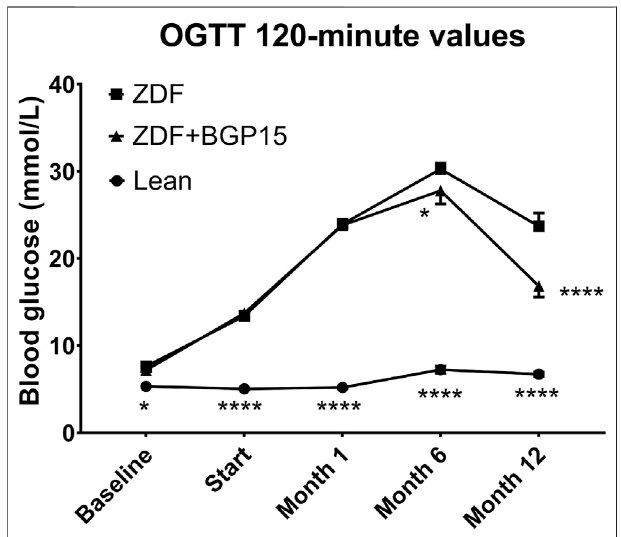
FIGURE 4 | Oral glucose tolerance test (OGTT) 120-min values during the study. Dataare presented asgroup means. Forabetter visibility,standard error of the mean (SEM) of some data points are plotted only in one direction, or not plotted at all, if error bars were shorter than the height of the symbol. * p < 0.05, **** p < 0.0001, both compared to ZDF group. Statistical analysis was done using GraphPad Prism: data were analyzed with the two- way analysis of variance (ANOVA)